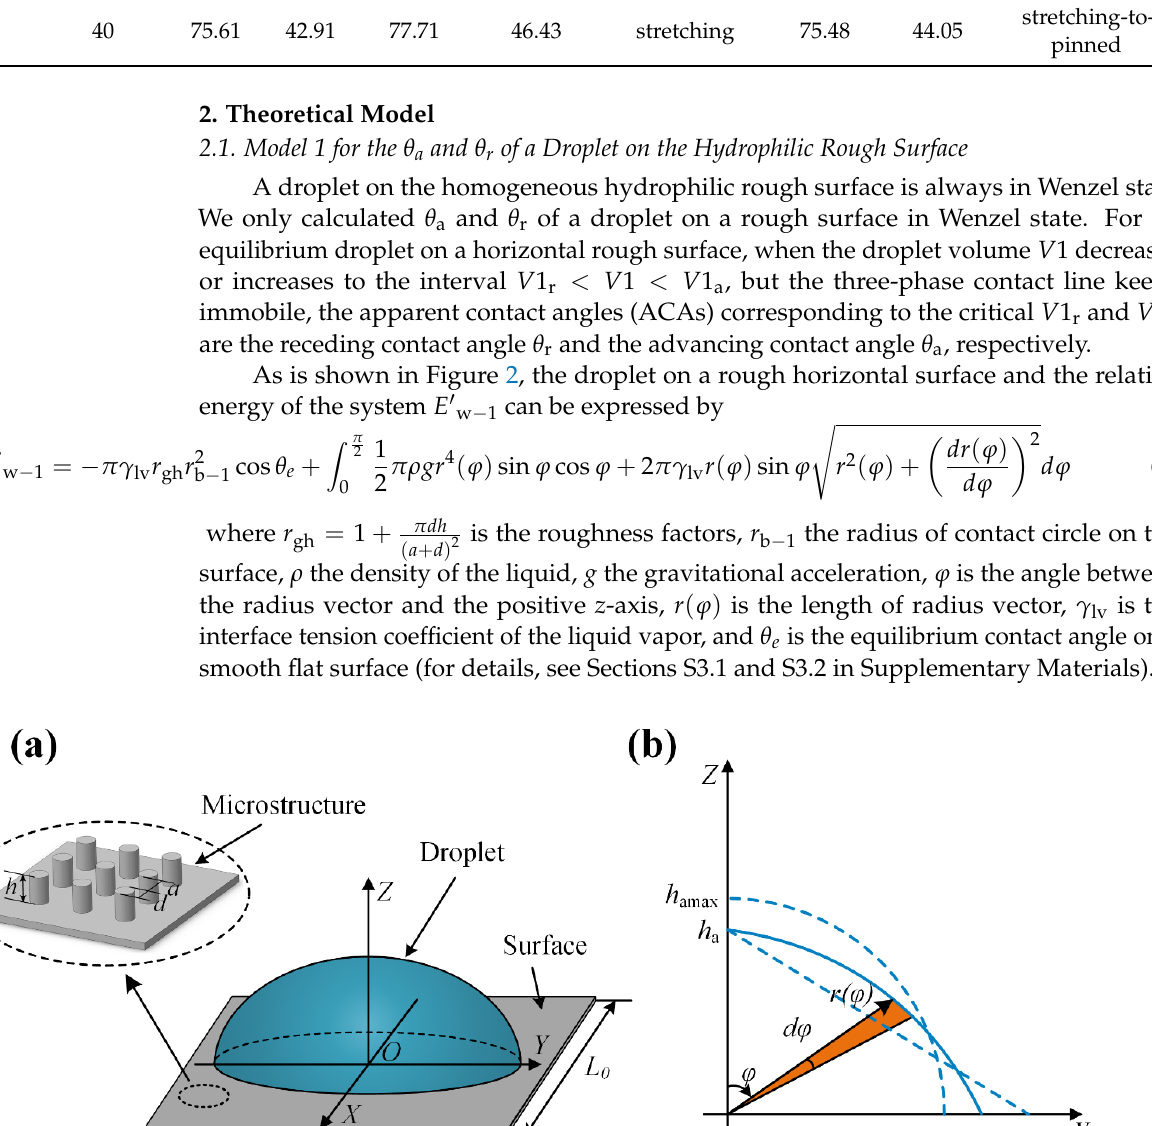
Table 1. Numerical results and motion state predictions for the droplet on an inclined, rough SiO 2 surface. Surface Tilt Angle/ ◦